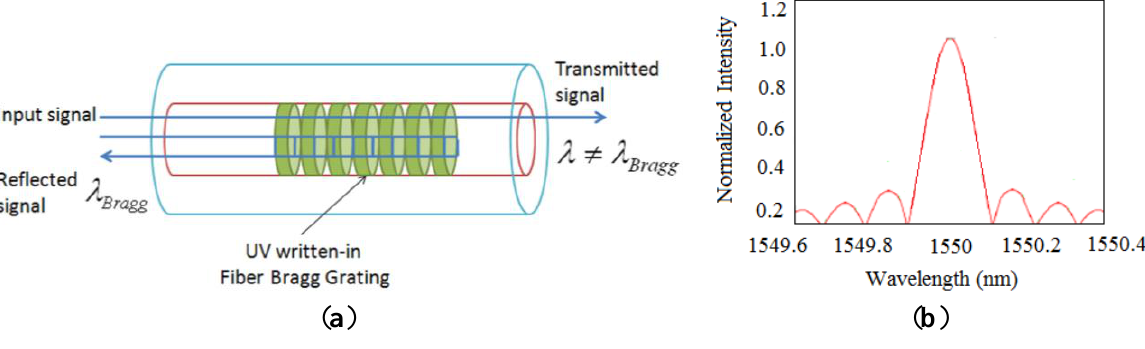
Figure 3. Operation principle of the FBG sensor and a typical spectrum. ( a ) The signal interrogation system of FBG; ( b ) Typical spectrum of FBG sensor.